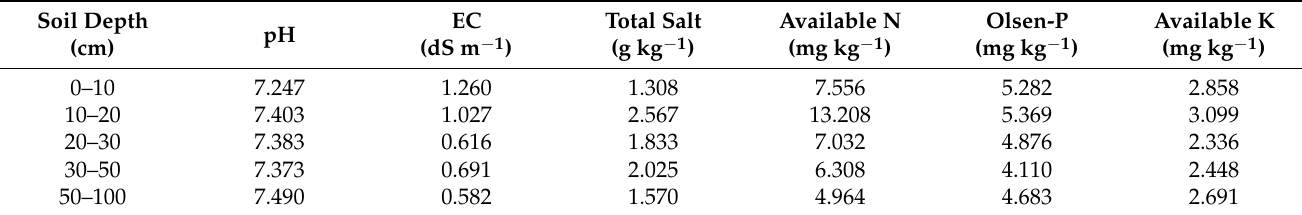
Figure 1. Monthly total precipitation, mean temperature, and maximum and minimum temperatures in the study area from NOAA ′ s National Centers for Environmental Information (NCEI). The shadow represents the main growing season of halophyte from May to Sep. Table 1. The field soil’s chemical and physical properties.